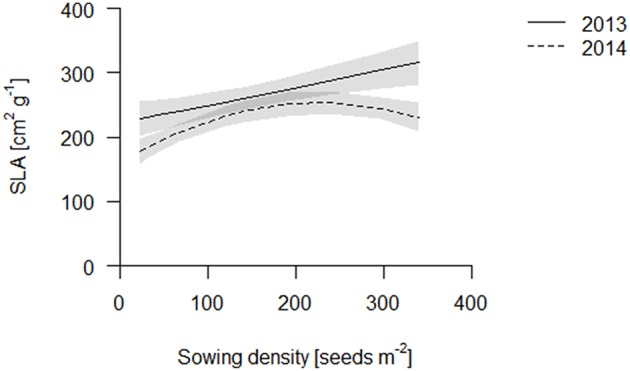
SLA of the coring in 2013 (solid line) and 2014 (dashed line). Data are presented as best fits with 95% confidence interval (gray). For equations, R2 and p-values see Table S2.